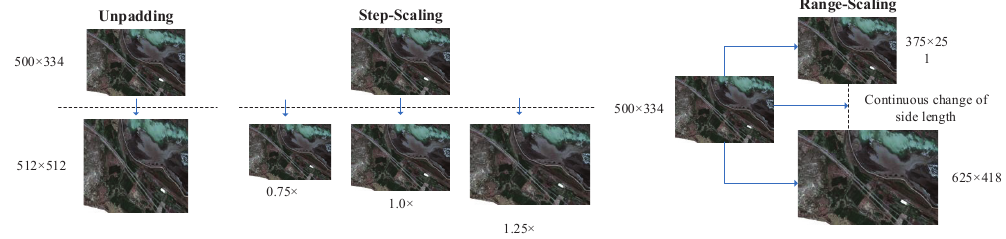
Figure 7. Part of data